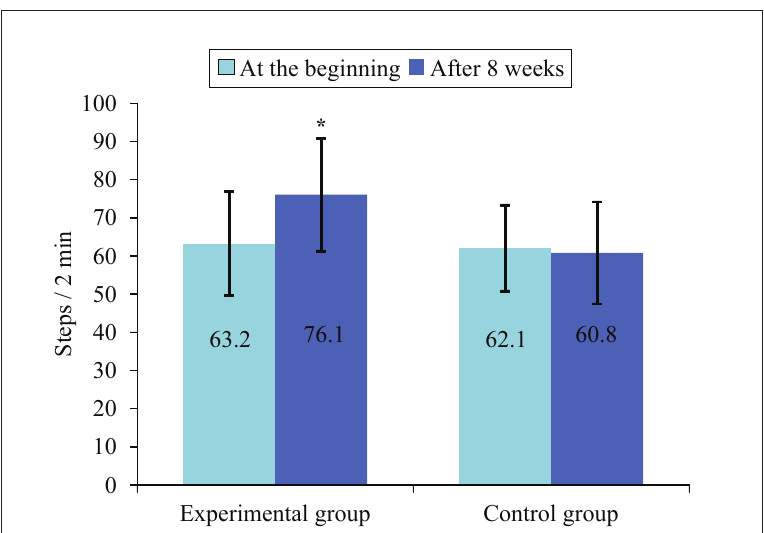
Note. * – statistically significant difference (p <